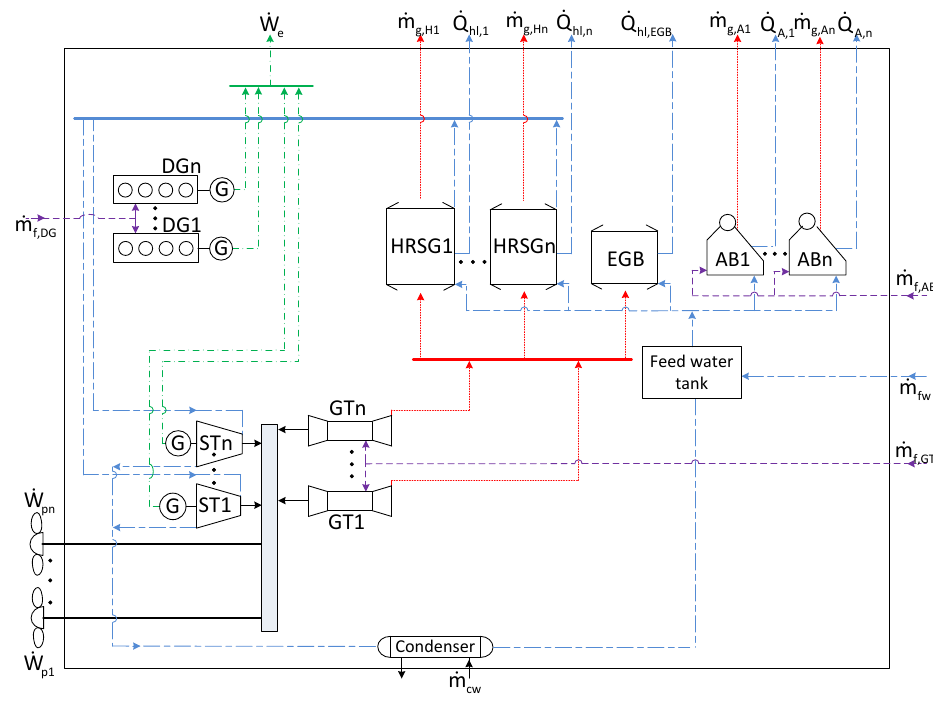
Figure 2. Superconfiguration of the energy system.